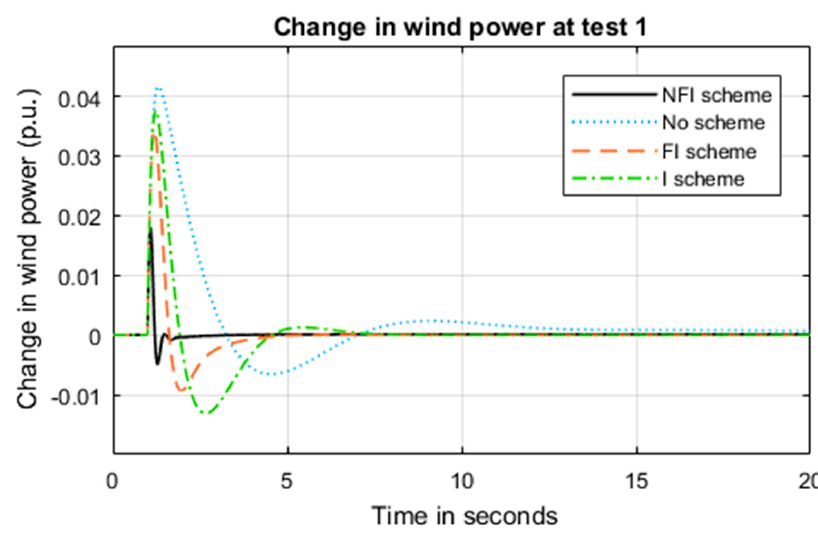
Figure 14. Change in tidal power when the system was subjected to test 1.